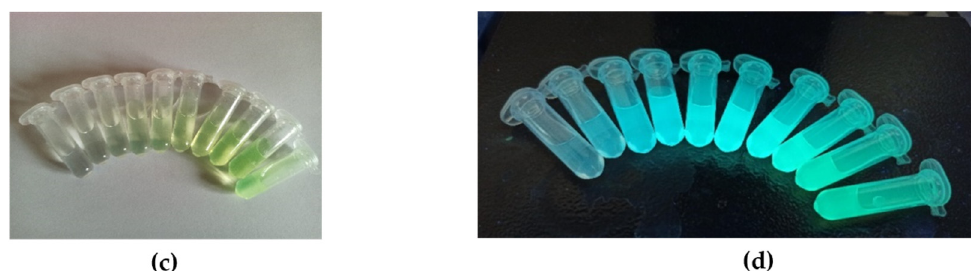
Figure 6. HOCl-induced oxidation of the BC-BA probe. ( a ) HPLC traces of the mixture of BC-BA , BC-OH and BC-H (20 µ M each) and the reaction mixtures of BC-BA (20 µ M) and BC-OH (20 µ M) with HOCl (20 µ M) after 15 min of incubation. Tests were conducted in aqueous solutions containing EtOH (10%), phosphate buffer (0.1 M, pH 7.4) and dtpa (10 µ M). The traces were collected using an absorption detector set at 330 nm; ( b ) HPLC based titration of the BC-BA probe (20 µ M) with HOCl (0–60 µ M). Pictures of the BC-BE probe (20 µ M) with different amount of HOCl (0–60 µ M): ( c ) in day light; ( d ) under UV.